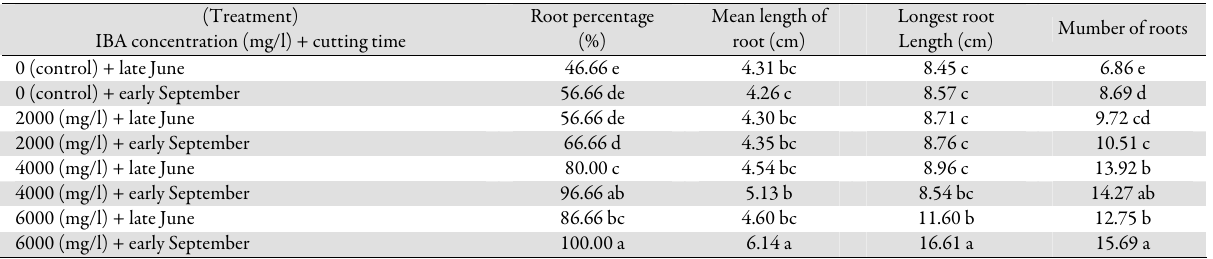
Tab. 2. Data mean comparison of treatments effect upon root percentage, mean length of root, longest root length and number of (Treatment)